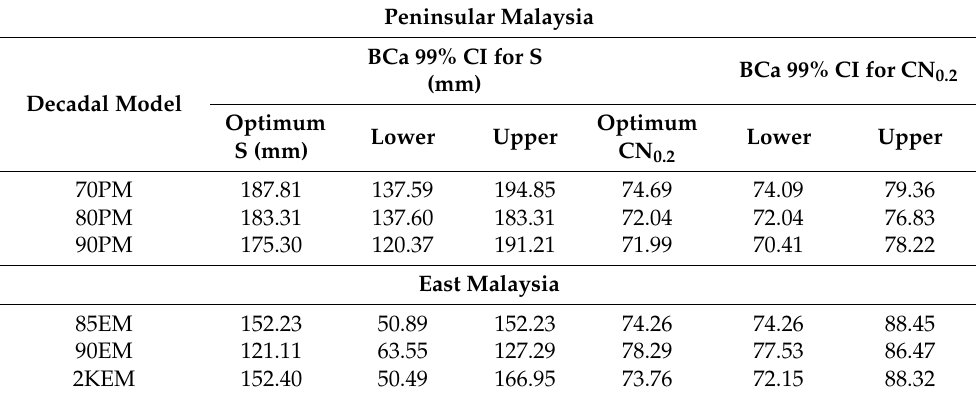
Table 5. The optimum S, optimum CN 0 . 2 , and its corresponding BCa 99% CI for both Peninsular Malaysia and East Malaysia.